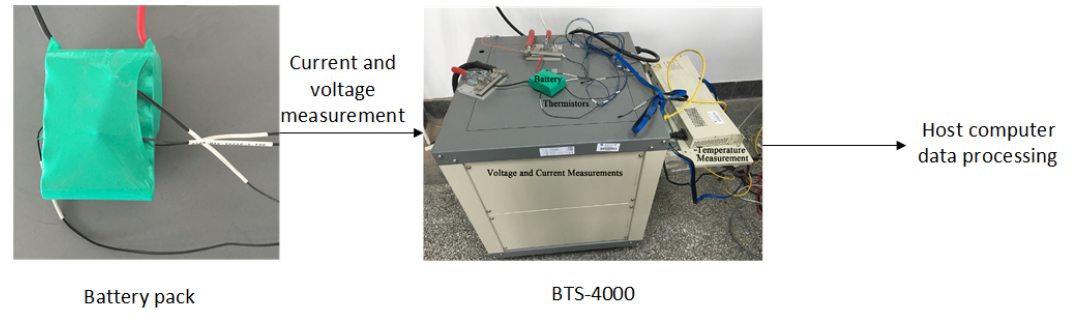
Figure 2. Test bench and